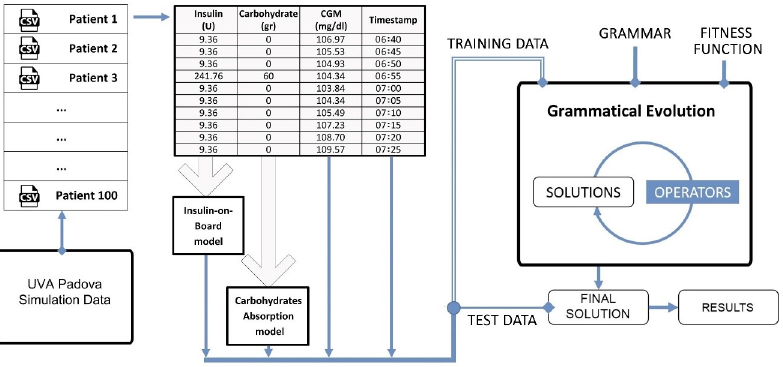
Fig 1. Schematic representation of the method used to generate prediction models for BG values.